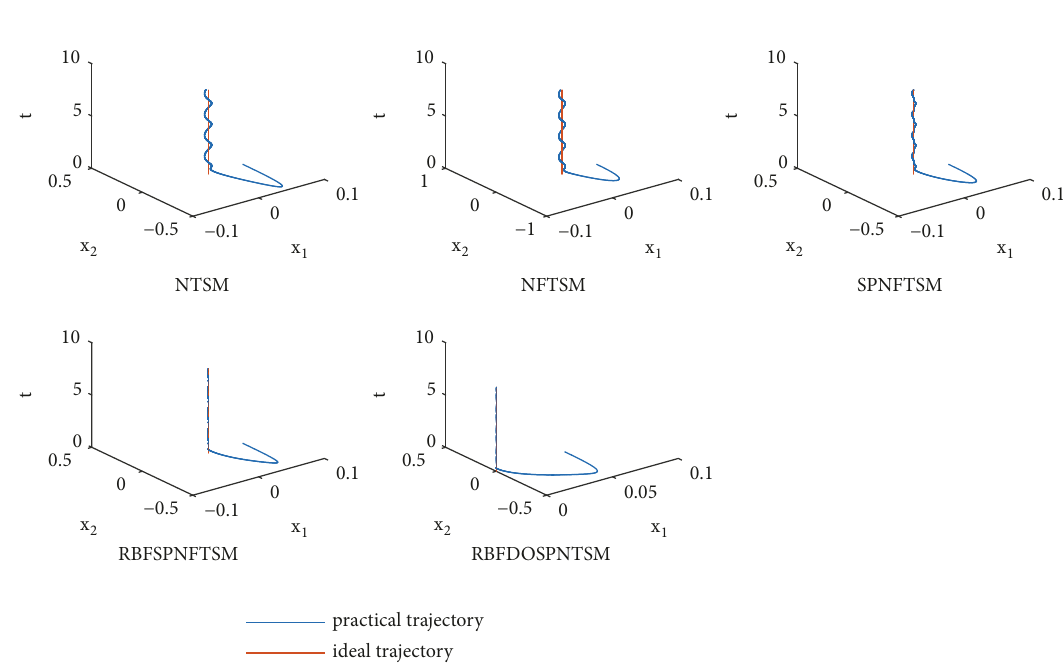
Figure 5: Sliding mode 𝑠 response curve.